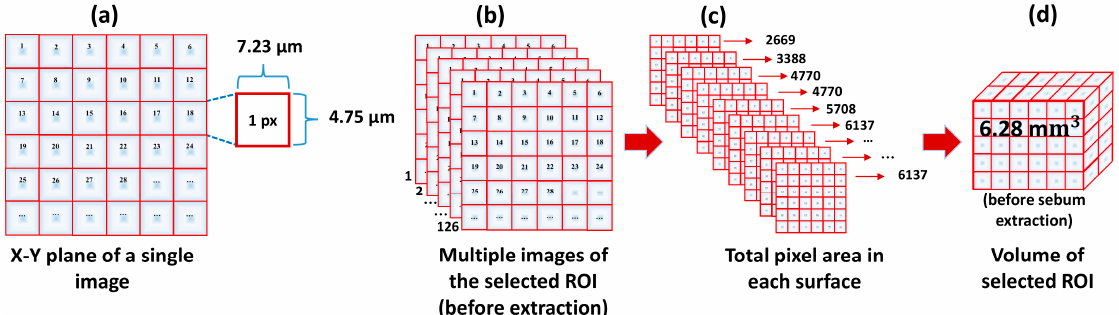
Figure 5c. All the surface areas were summed together to determine the volumetric size of the pore. The volume of the 3D object (skin pore and hole) was calculated, and the volume is represented as a 3D object in Figure 5d.